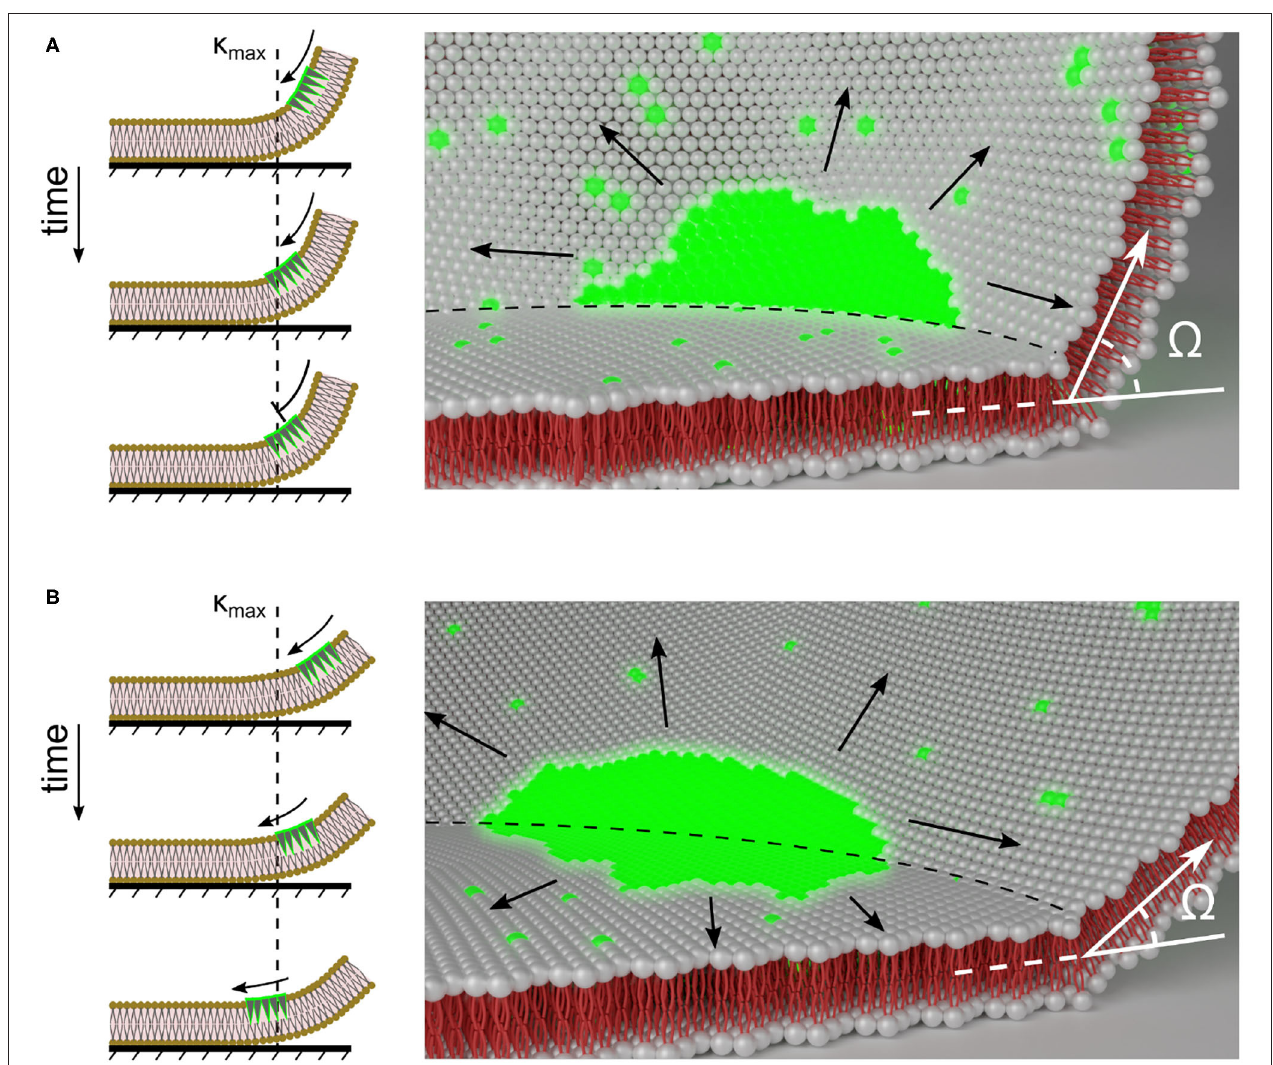
FIGURE 7 | Scheme of membrane curvature regulated PIP3-domain signaling at the contact perimeter. PIP3-domain diffusion across the contact perimeter depends on the degree of local membrane curvature. (A,B) show illustrations of differently sized cells that have large and small membrane curvatures, κ at the contact perimeter, and the influence of the contact perimeter on the PIP3-domain (green) propagation. The left panels show the one dimensional view of PIP3-domain propagation. κ max shows the position of the contact perimeter and the membrane location with highest degree of curvature. The black arrows indicate the direction of PIP3-domain propagation. The right panels show the two dimensional view. The black arrows indicate possible directions of PIP3-domain propagation that may also lead to anchored waves at the contact perimeter (dashed line). The contact angle (cid:127) is representatively shown at the contact